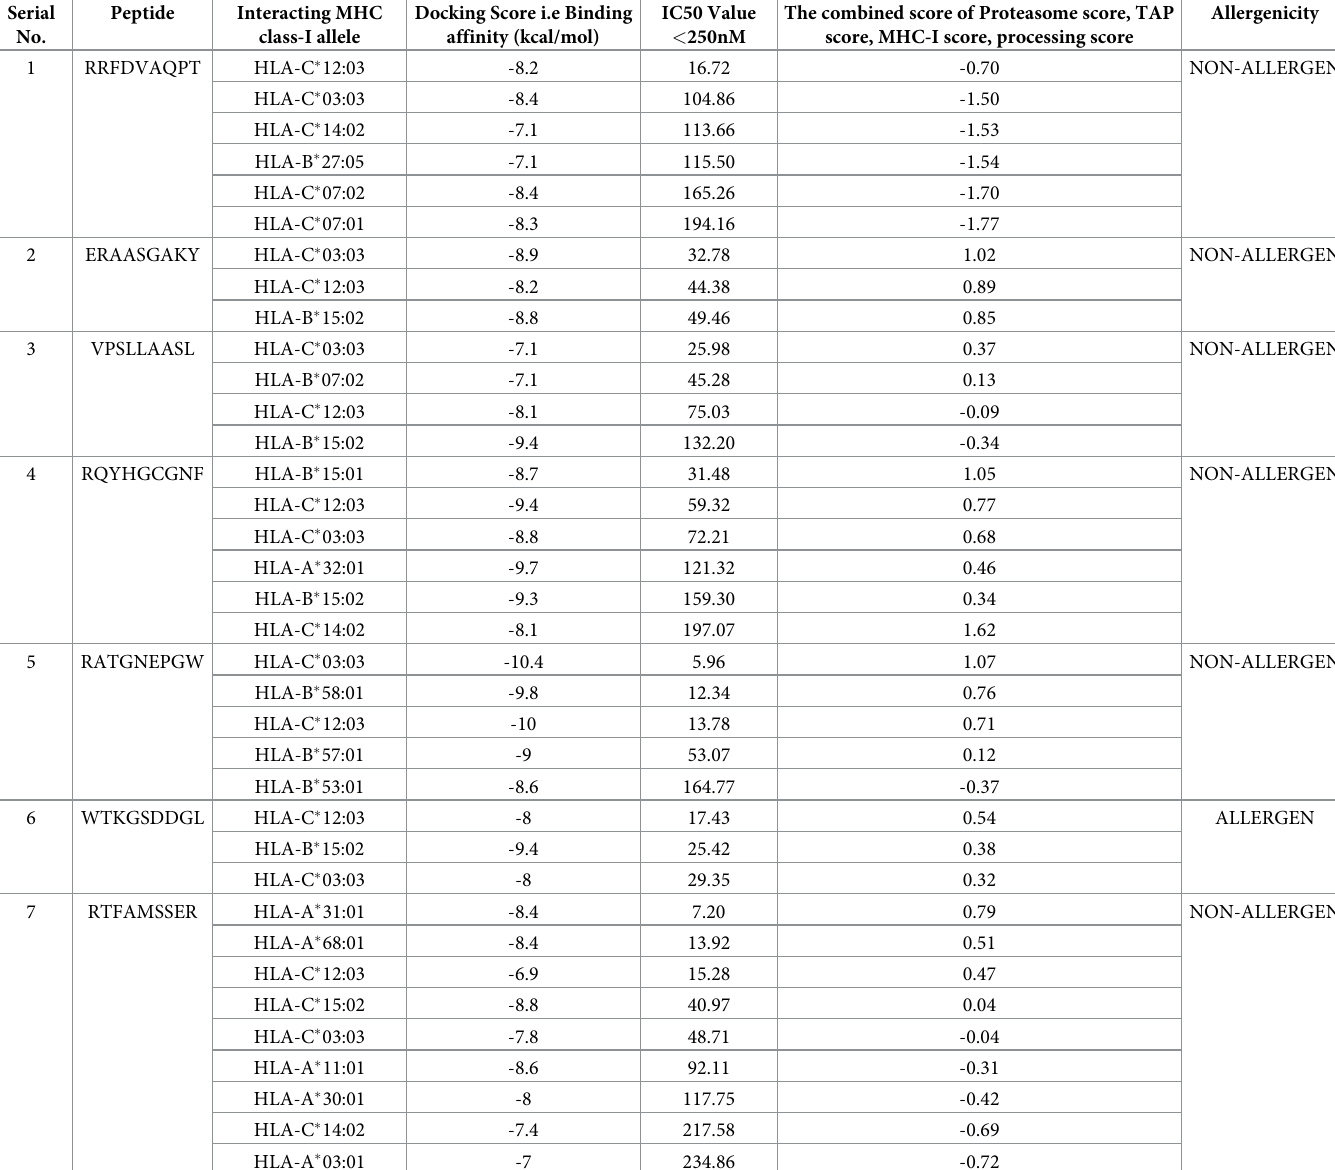
Table 6. Promising T cell epitopes with their properties: IC 50 value, docking score (kcal/mol), combinatorial processing score. Serial